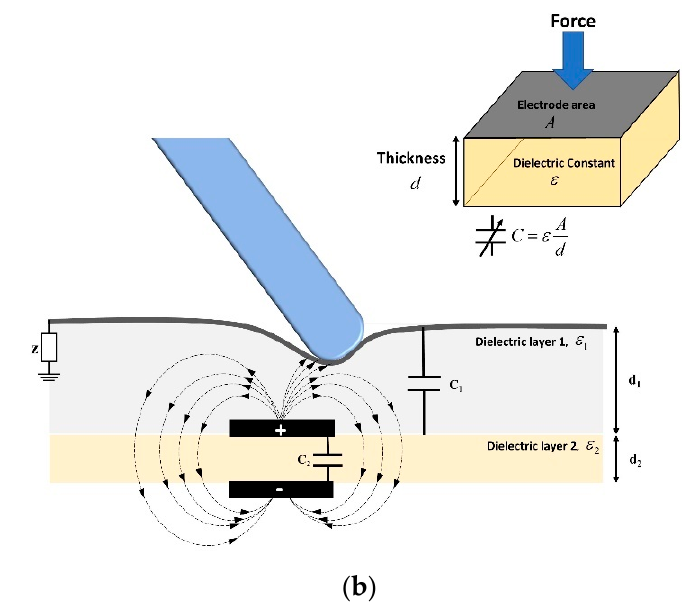
Figure 2. Schematic view of the working principles for the ( a ) typical capacitive sensor and ( b ) pro- posed sensor.